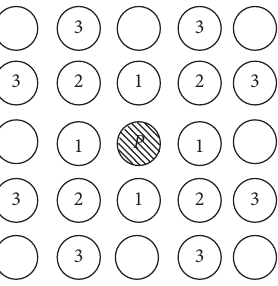
Figure 2: Schematic of the radiation model between rods.